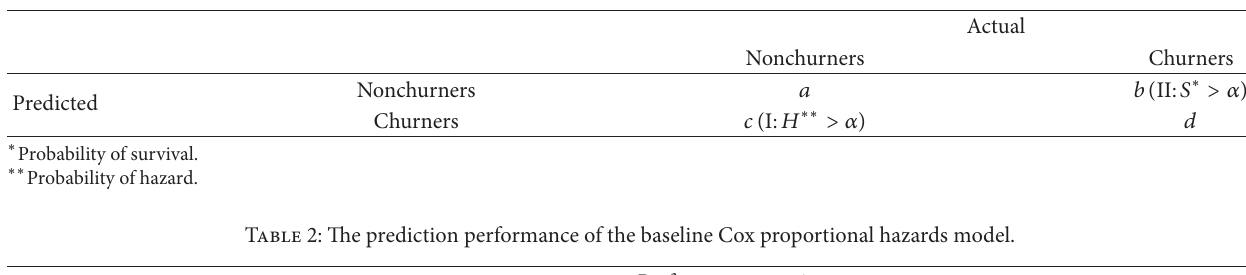
Table 1: Confusion matrix.